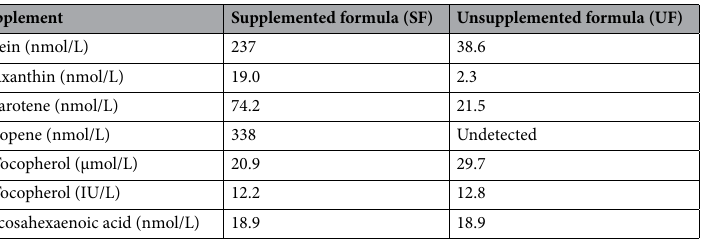
Table 1. Concentration of carotenoids, a-tocopherol and docosahexaenoic acid in infant formulas fed to infant rhesus